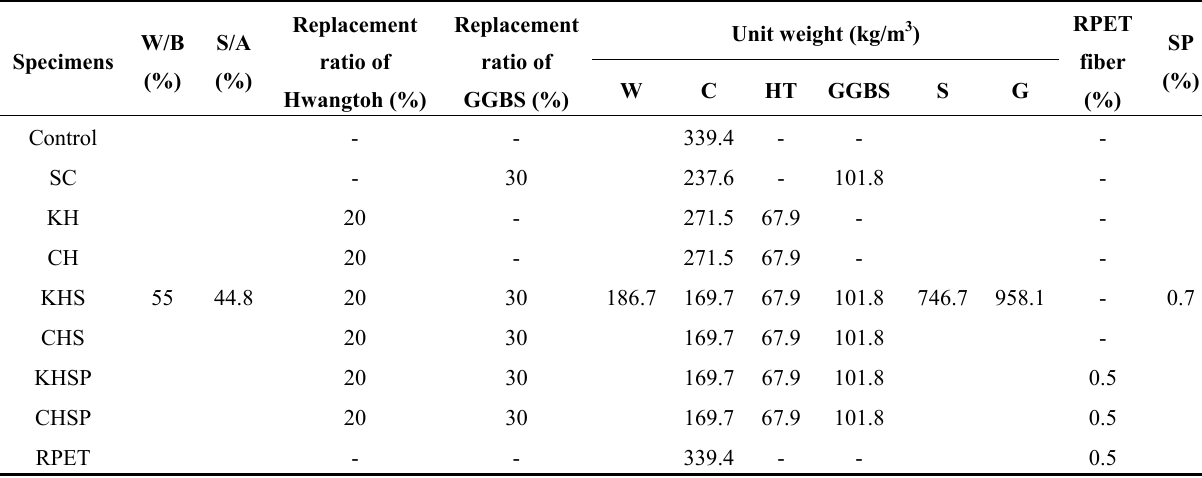
Table 2. Concrete mixture